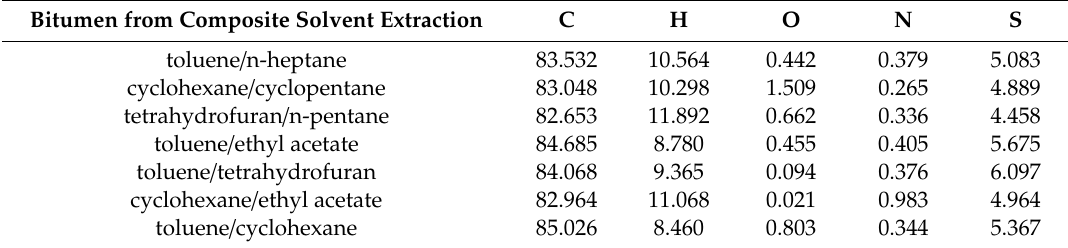
Table 4. The elemental analysis of bitumen (wt%) from composite solvent extraction.